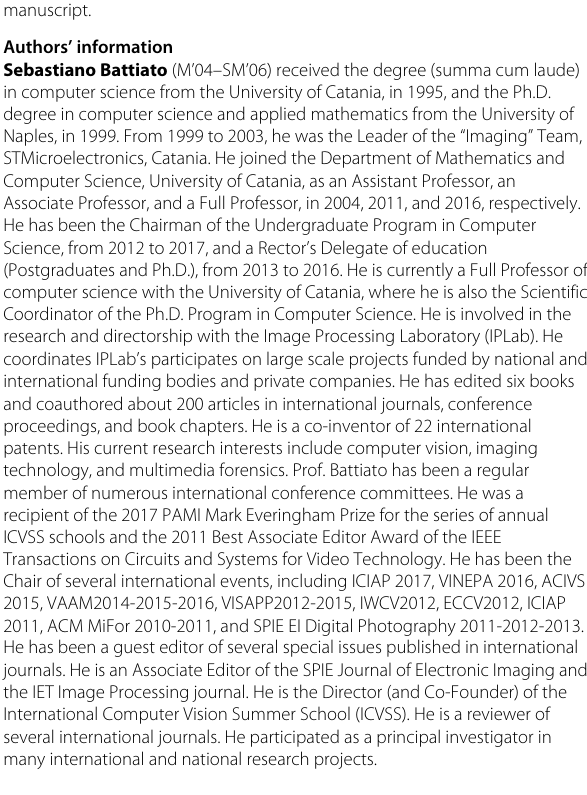
The columns (60,65,...,95) represent the QF